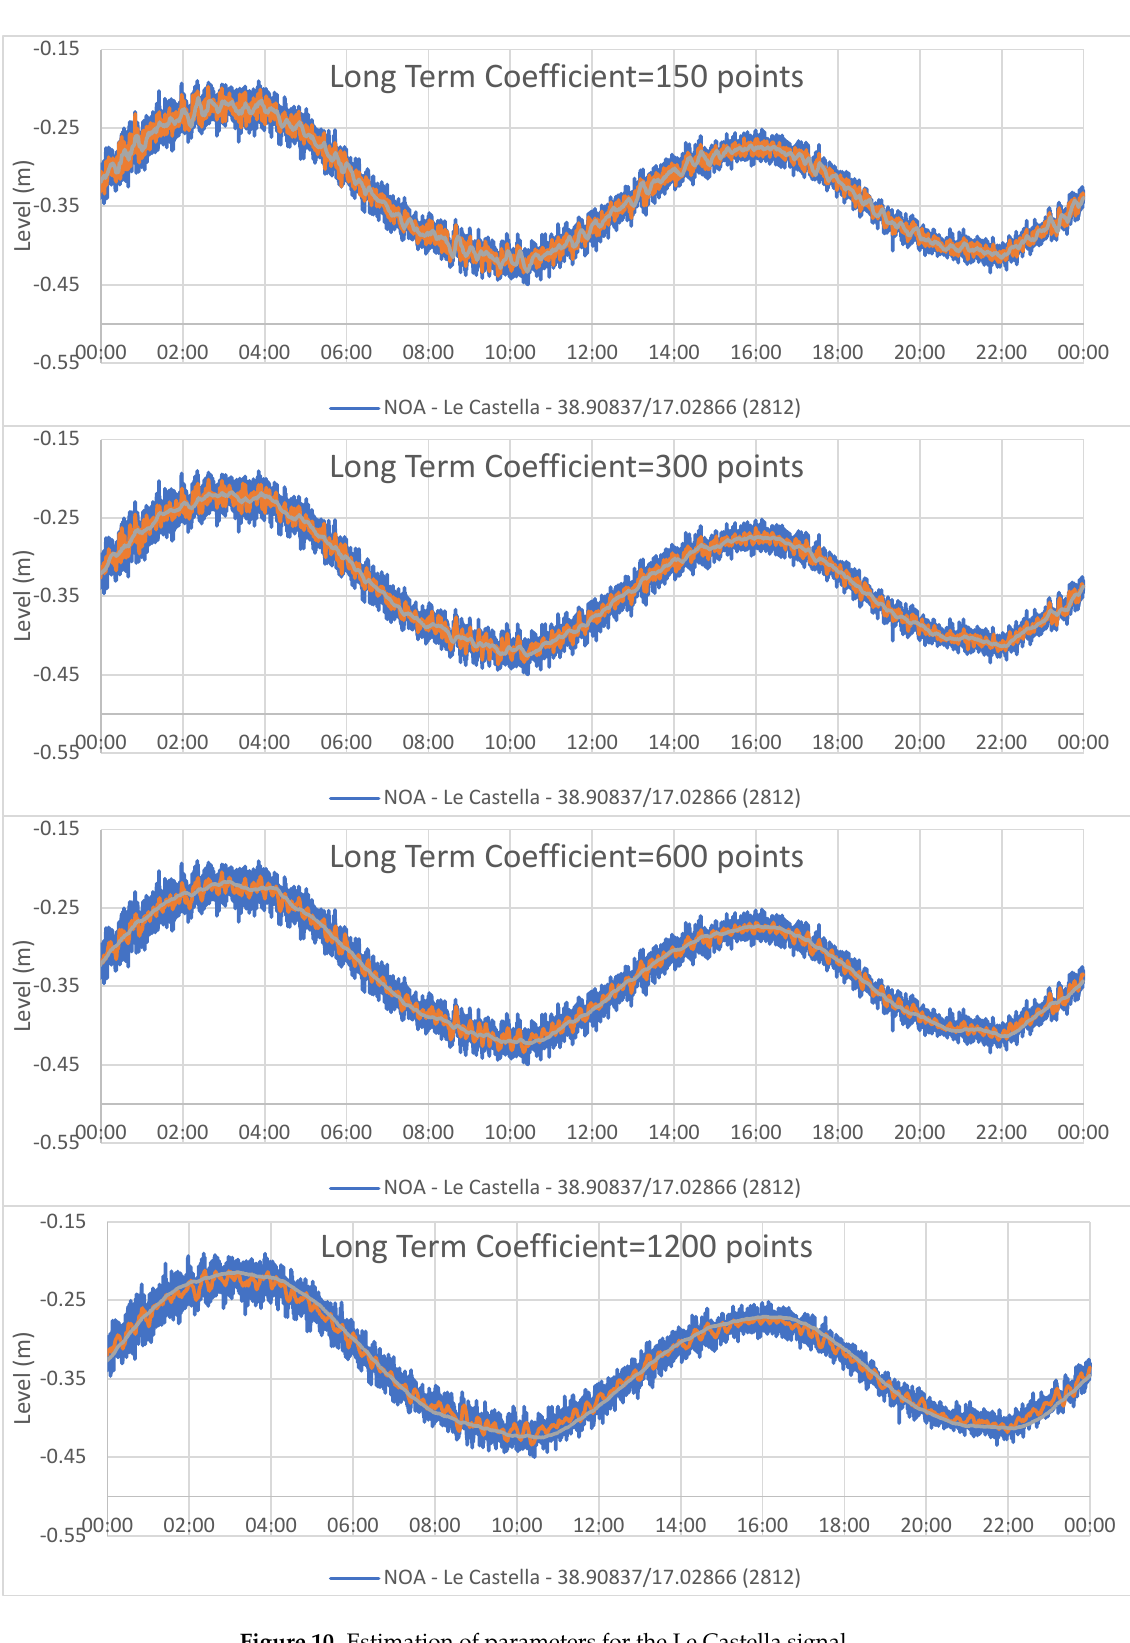
Figure 10. Estimation of parameters for the Le Castella signal.